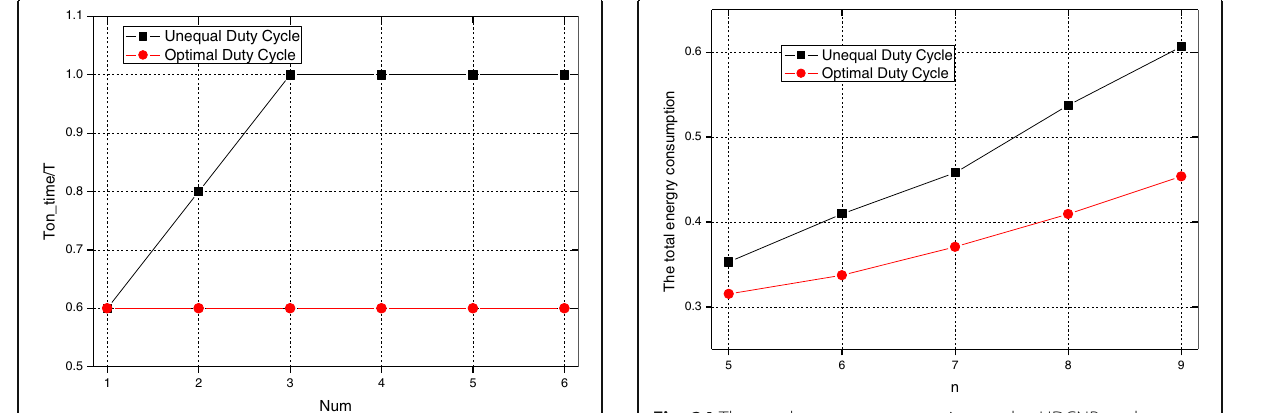
Fig. 24 The total energy consumption under UDCNP and OPCNP (MPSK)